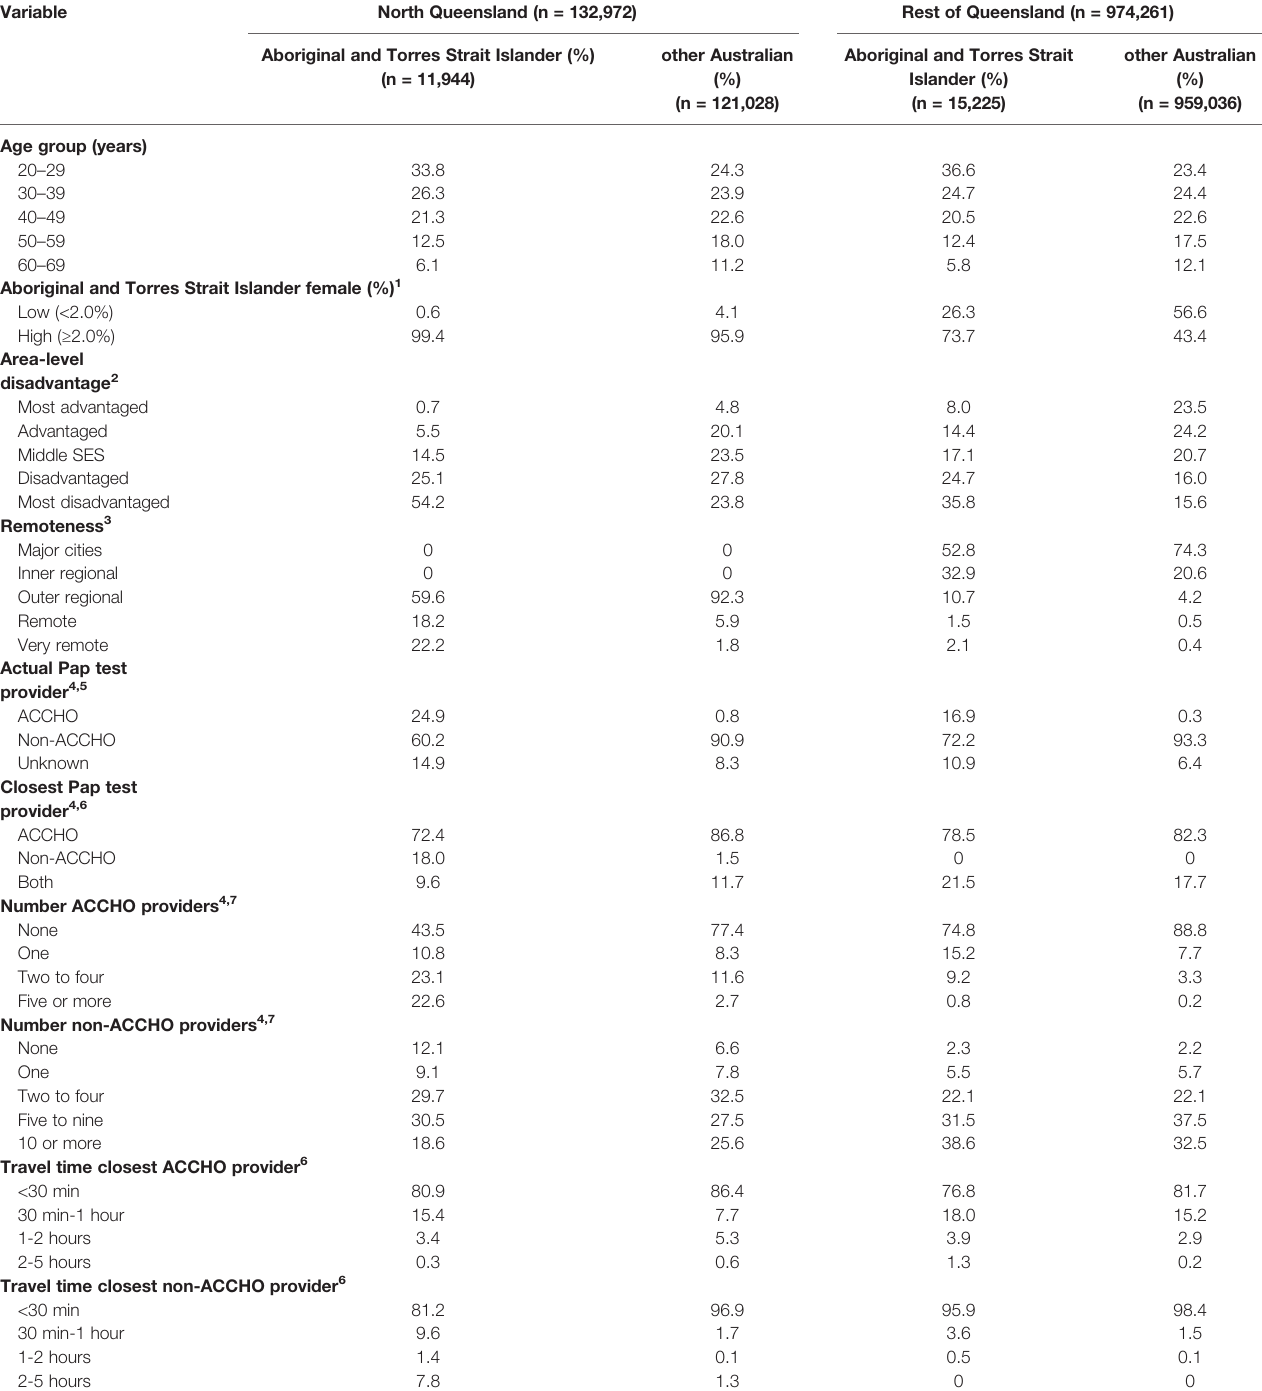
TABLE 2 | Characteristics of screened women, Queensland 2013 – 2017 by region and Aboriginal and Torres Strait Islander status at time of fi rst Pap test.